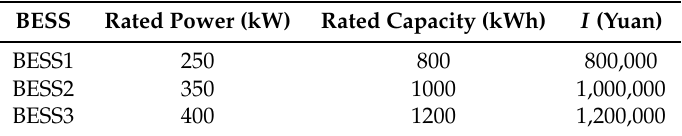
Table 2. Parameters of the battery energy storage systems